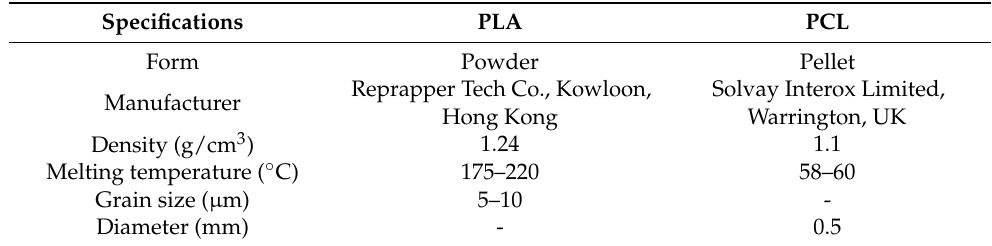
Table 1. The properties of the polycaprolactone (PCL) and polylactic acid (PLA) [17].